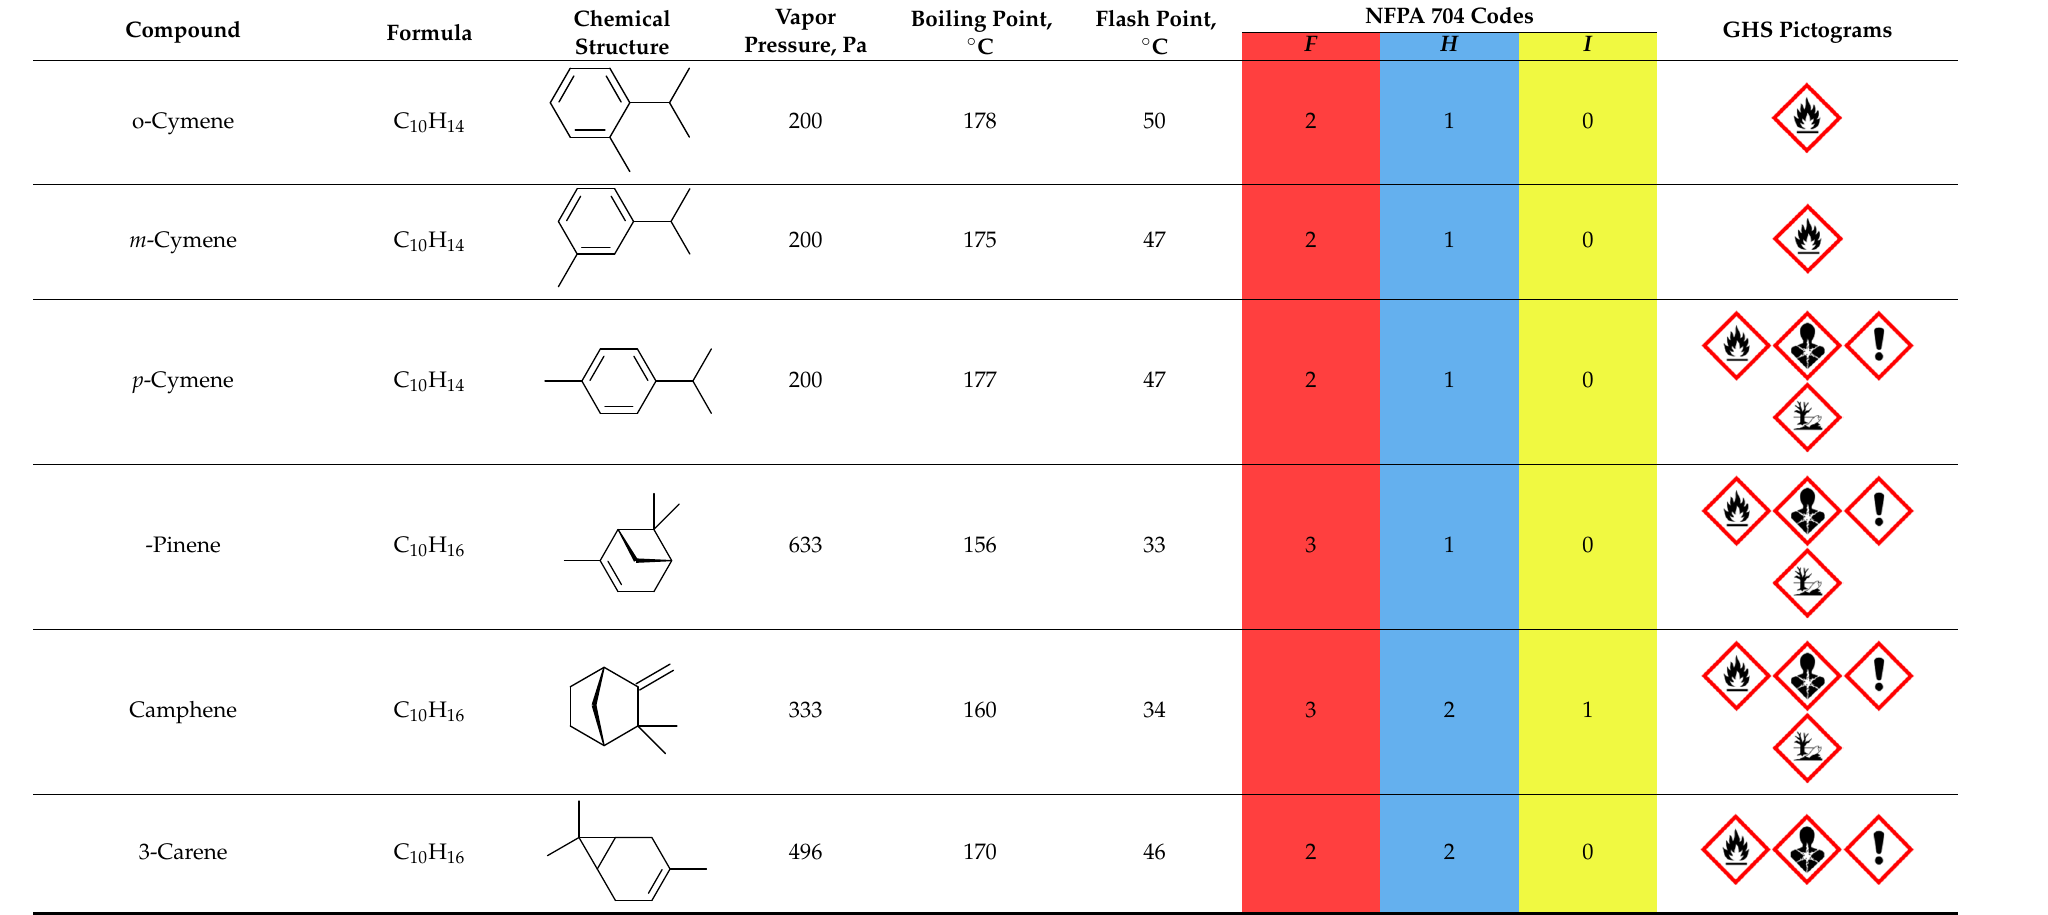
Table 2. Volatile organic compounds detected during the extrusion treatment of BSG.